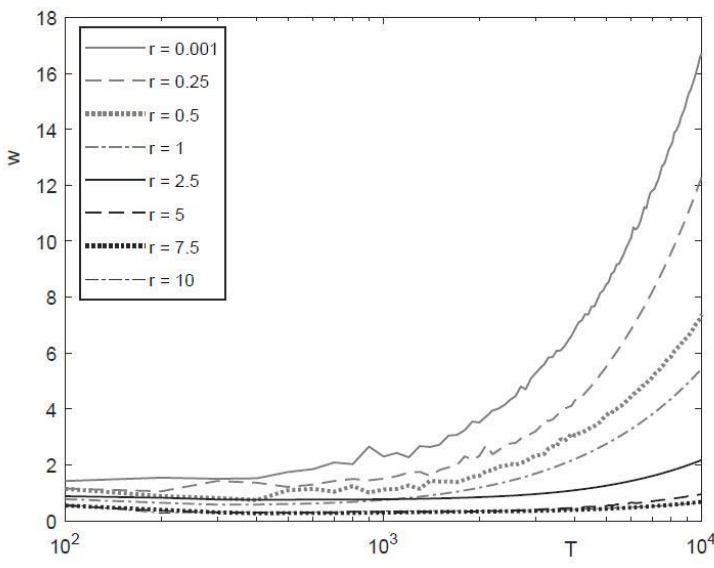
( t ) for several values of r in